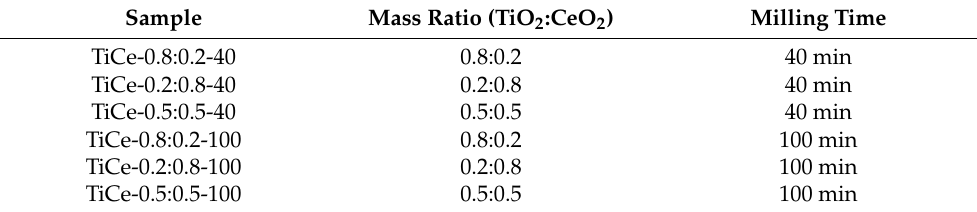
Table 1. Labelling of the samples after mechanochemical treatment. Sample Mass Ratio (TiO 2 :CeO 2 ) Milling